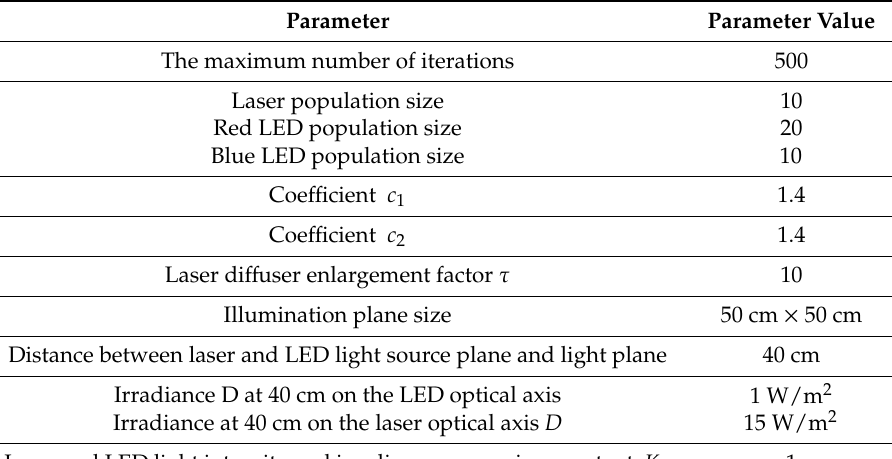
Table 1. Initial parameters of particle swarm